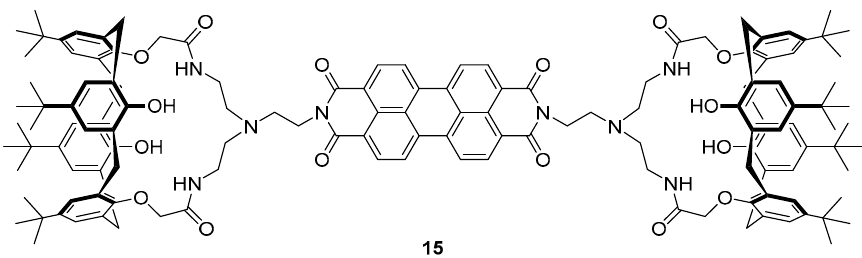
Figure 8. This perylene-based calix[4]arene 15 adopts a cone conformation and functions as a turn-on probe for Hg 2+ . The metal ion coordinates to the three aza-crown nitrogen atoms and the nitrogen of the perylene, thus disrupting PET and enhancing fluorescence output [88].